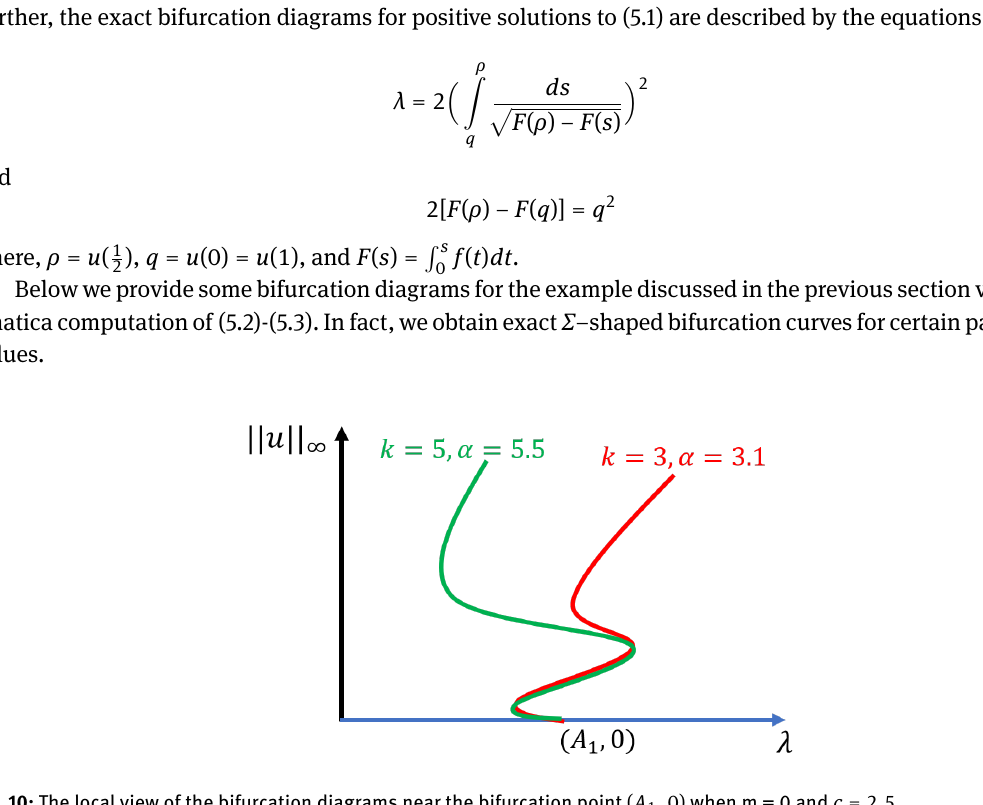
Fig. 10: The local view of the bifurcation diagrams near the bifurcation point ( A 1 , 0) when m = 0 and c = 2.5